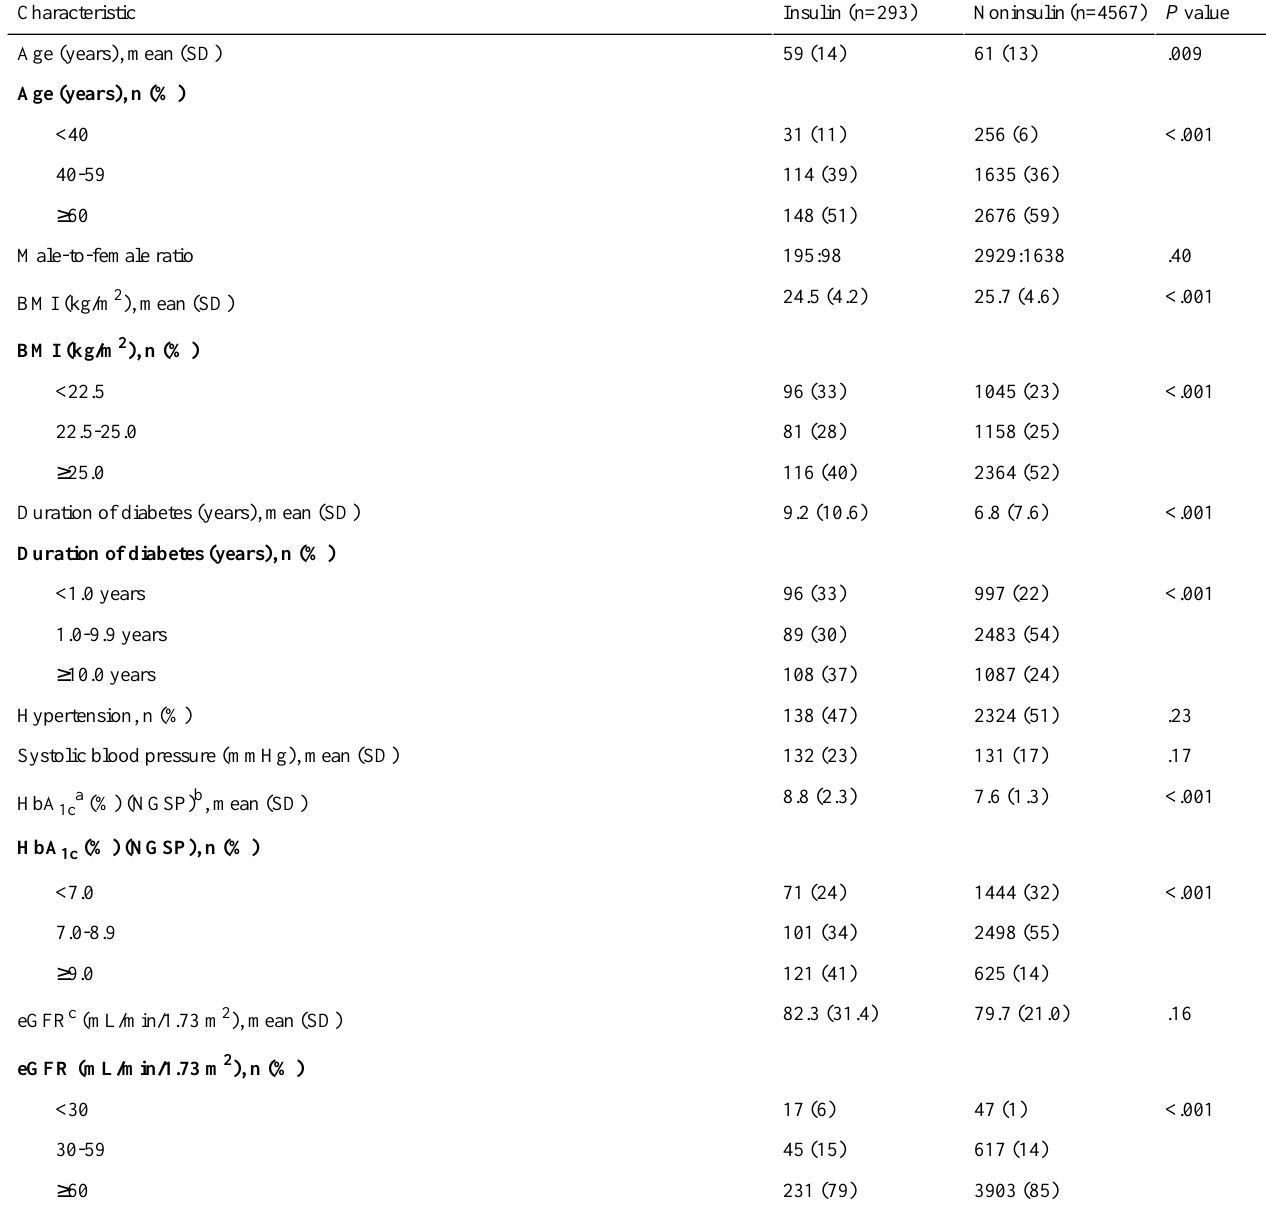
Table 1. Characteristics of study participants according to prescription of insulin or another hypoglycemic drug.